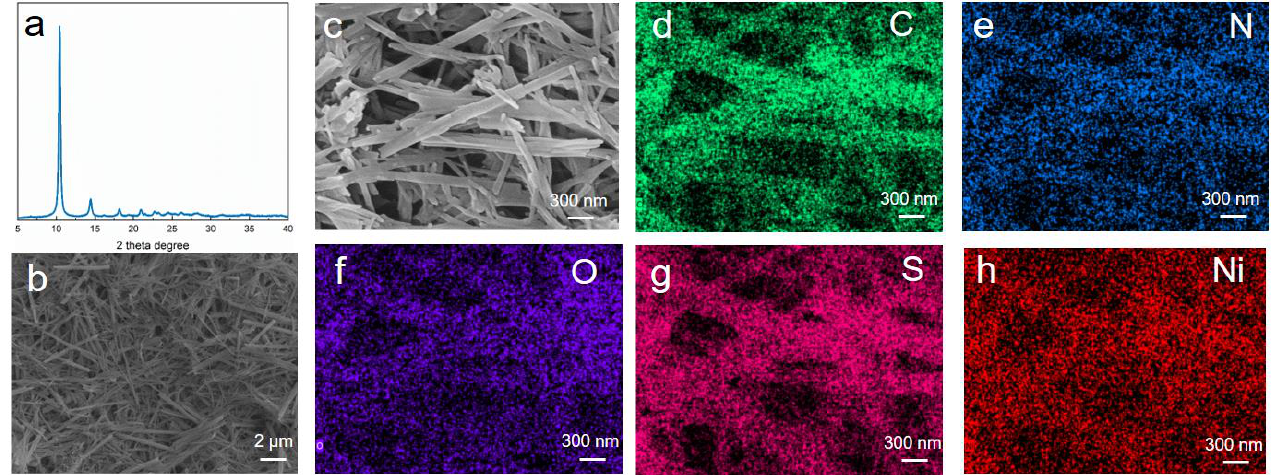
Figure 1. ( a ) XRD pattern ( b , c ) SEM and ( d – h ) the corresponding EDS mapping images of as-prepared Ni-MOF nanorods.